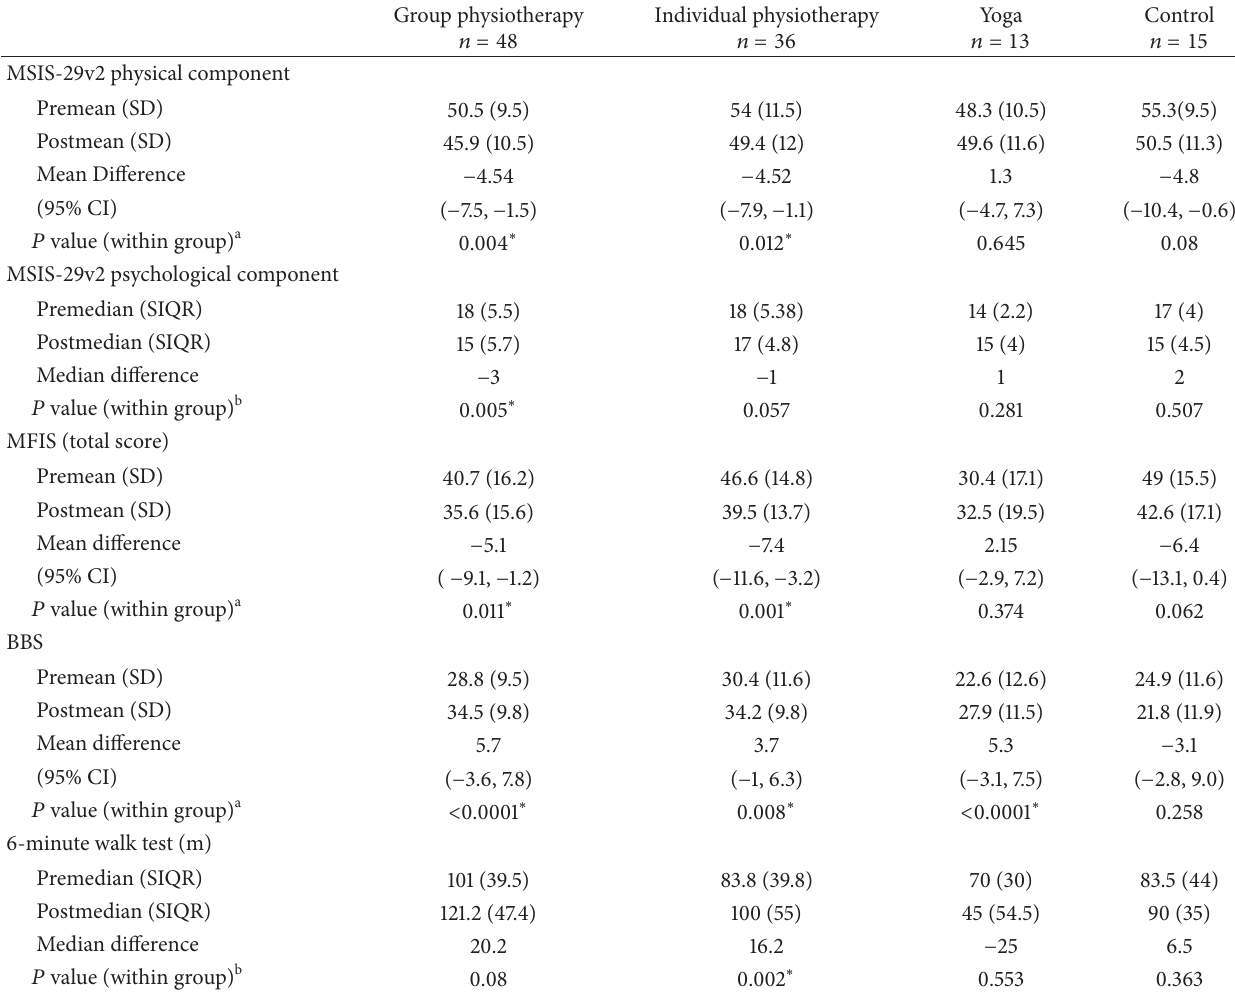
Table 3: Descriptive statistics for study outcome